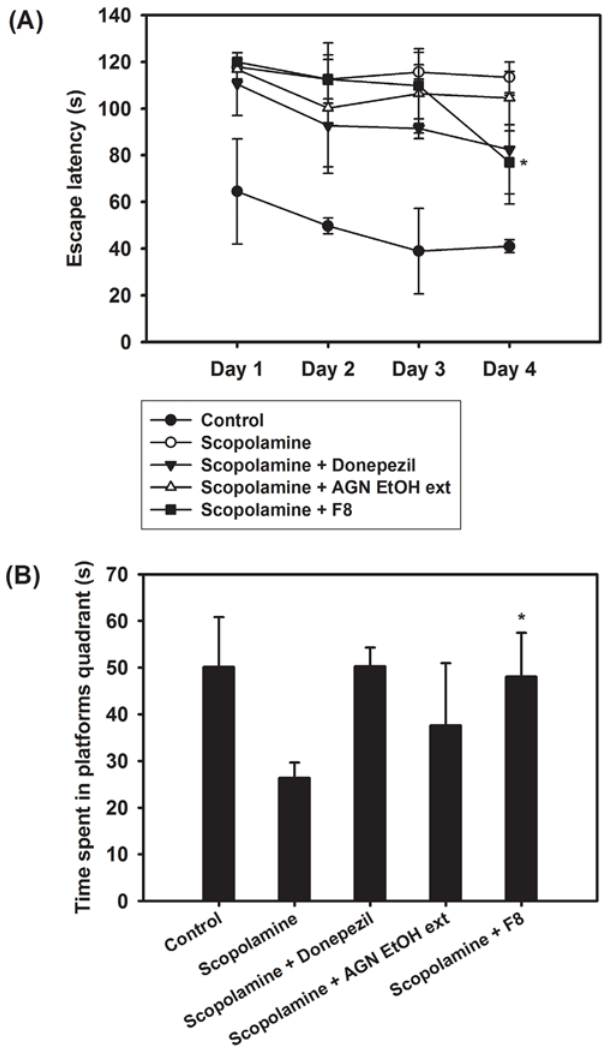
of EtOH ext of AGN per body weight). (B) Time (s) in target quadrant was shown after probe trial test. * p < 0.05, compared to scopolamine-treated group. Each point represents mean ± SD (n = 4 – 6). Two-tailed t - test is used for the statistical